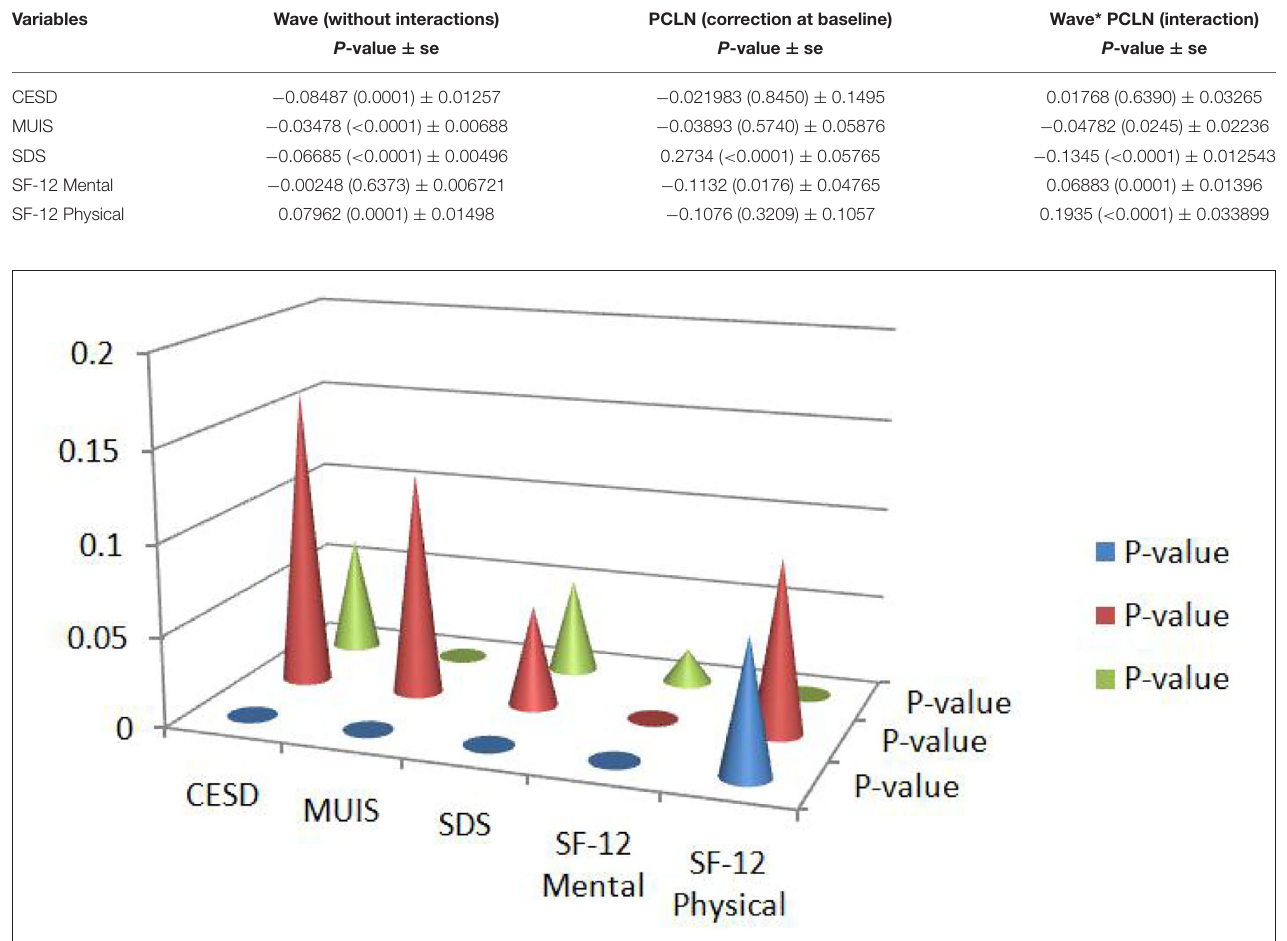
FIGURE 2 | Graphical representation of p of the variables